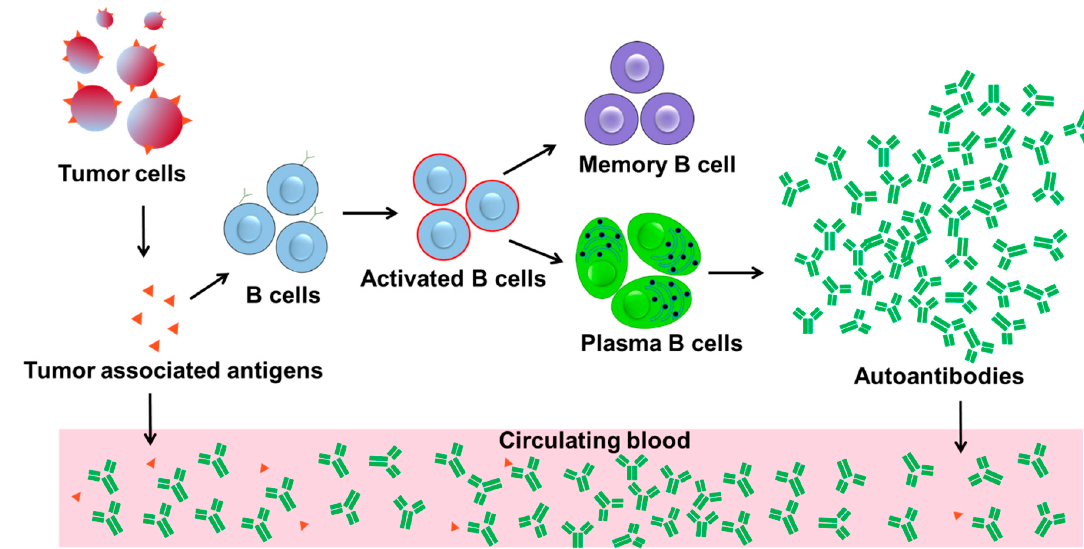
Figure 1. Schematic diagram of autoantibody production and amplification by cancer antigen stimulation. B cells produce many copies of autoantibodies during immune responses, which amplify the cancer antigen “signal”, becoming detectable during early-stage breast cancer. In comparison, the concentration of antigens is too low to be detected in the same timeframe.